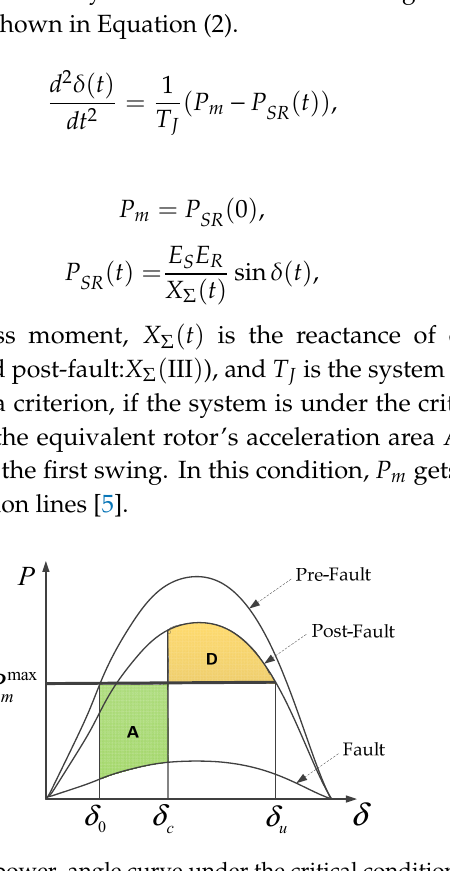
Figure 3. Transient process power–angle curve under the critical condition of transient stability. The difference between area D and area A is zero.